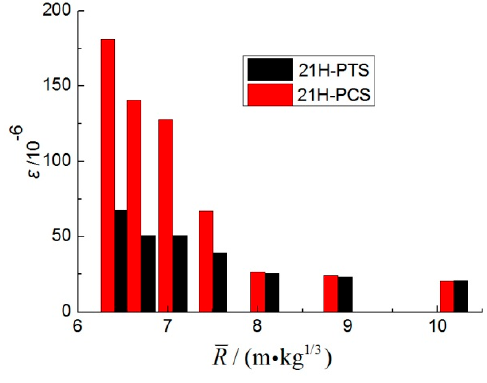
Figure 8. The PTS and PCS of 21H ( R = 3.75 m).